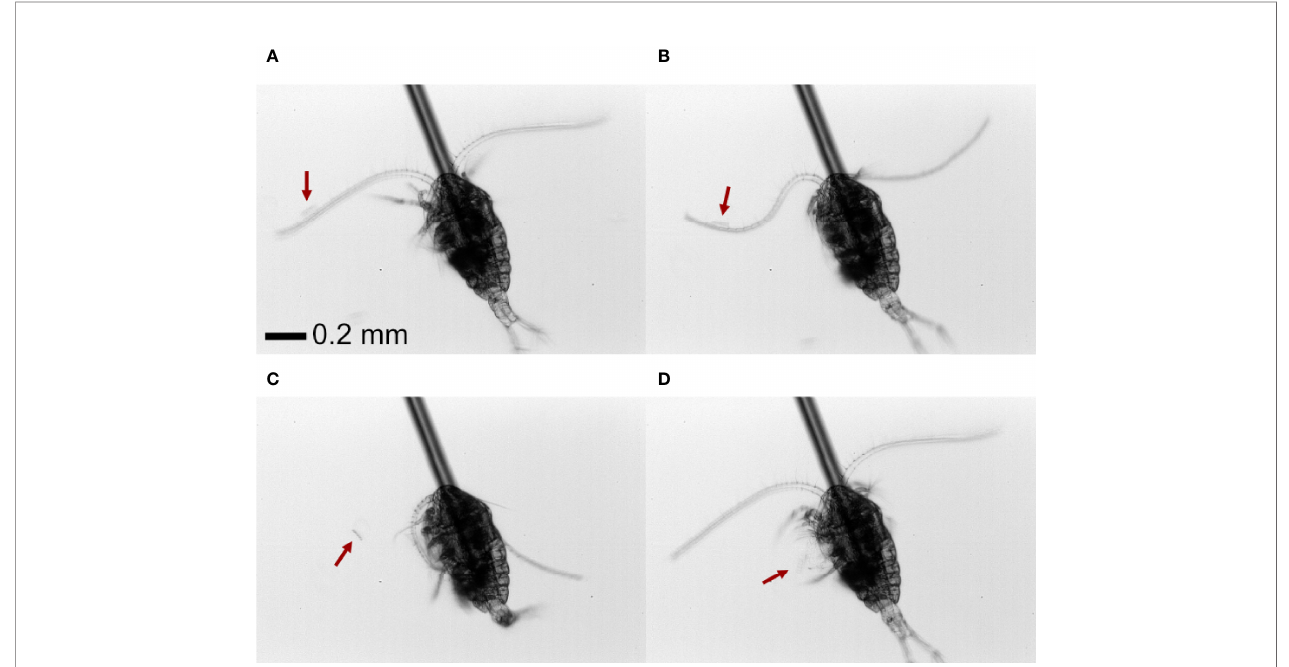
FIGURE 1 | Front view of (A) a T. nordenskioldii diatom chain (~60 µm length) coming into contact with the antennae of a T. longicornis copepod. (B) The copepod swings the antennae, (C, D) moving the chain towards the feeding current and feeding appendages. The position of the chain is indicated by the red